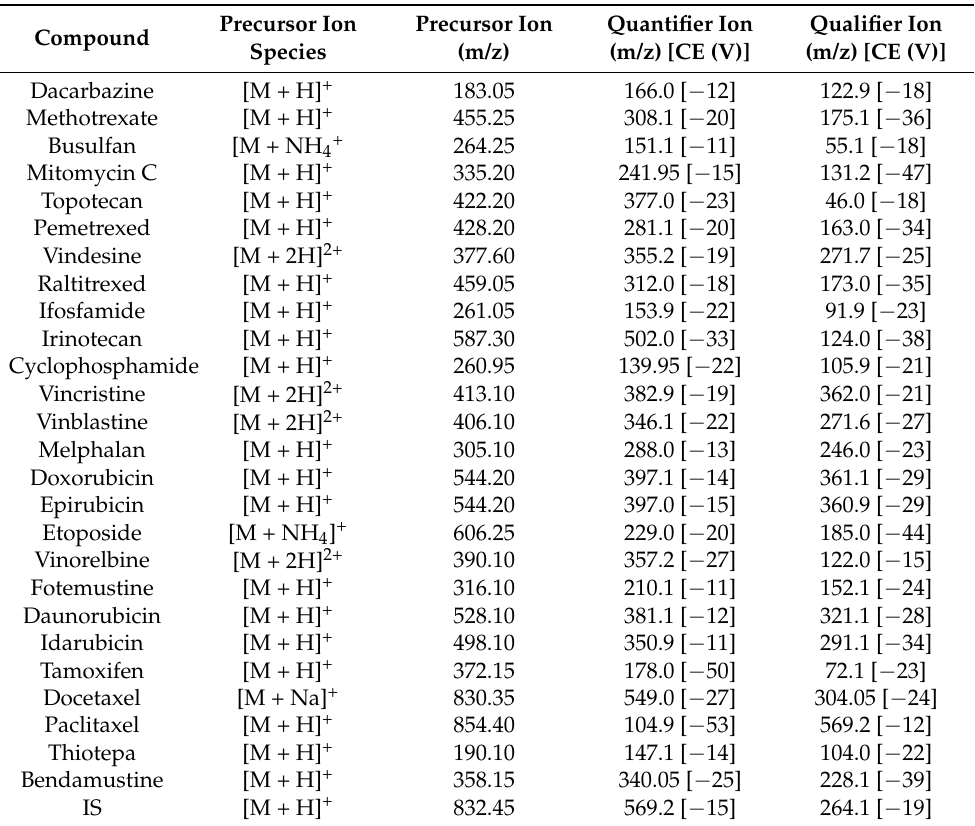
Table 3. Optimized parameters set in MRM mode, showing the quantifier and qualifier ions for each analyte with the corresponding collision energy (CE)